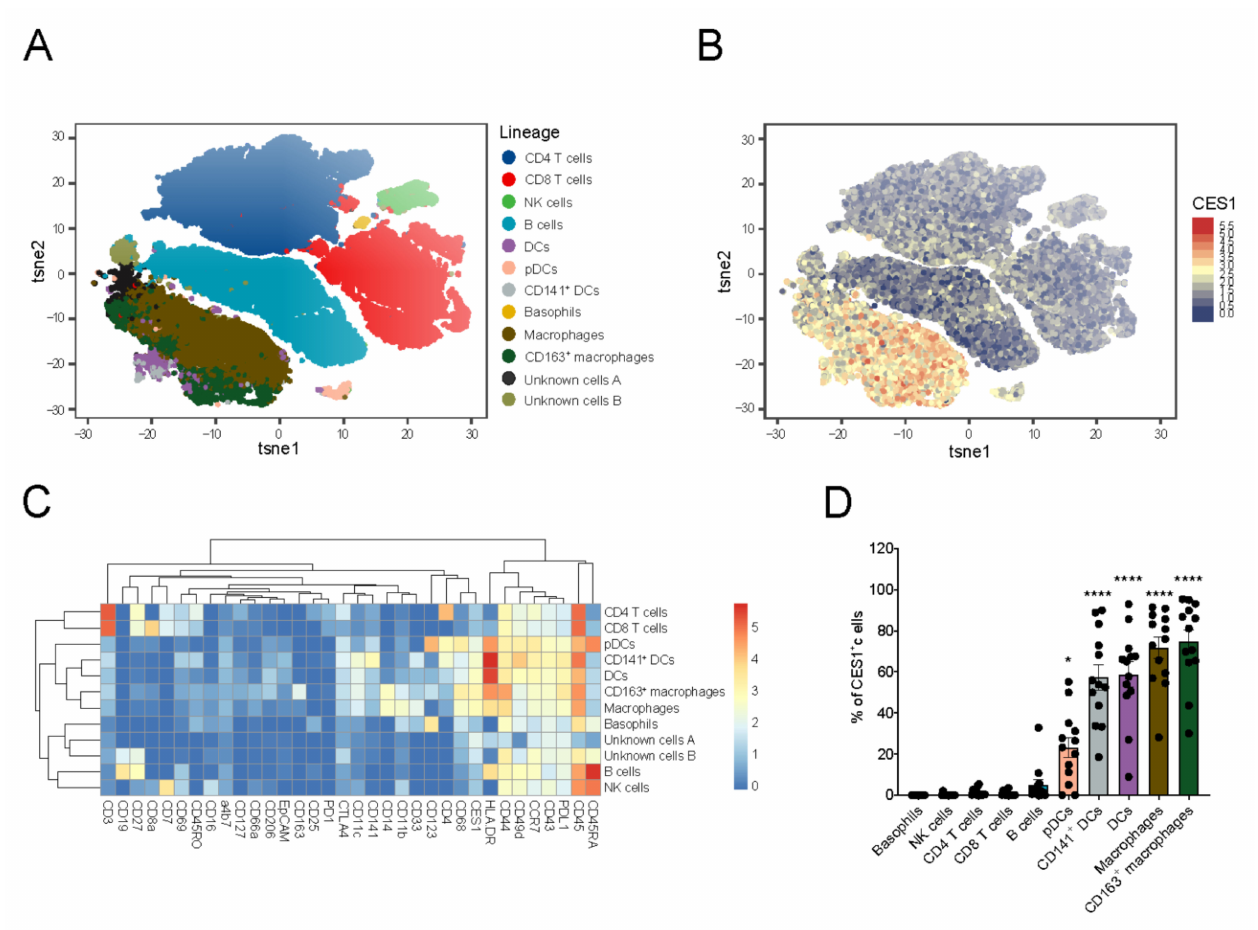
Figure 3. CES1 is expressed within macrophages and dendritic cells retrieved from inflamed fis- tula tracts of CD patients. ( A ) Fistula cells from CD patients (n = 13) fistula tract scrapings were barcoded, stained, and pooled for CyTOF and then visualized in a tSNE plot after mass cytometry analysis. Basophils, B cells, CD141 + DC type1, CD4 T cells, CD8 T cells, NK cells, macrophages, CD163 + resident macrophages, pDCs, and DCs were identified. ( B ) CES1 expression was demon- strated among identified cell clusters in ( A ). ( C ) A heat map showing expression intensity of different (lineage) markers in relation with the identified cell clusters in ( A ). ( D ) Percentages of CES1 + cells are shown among identified cell clusters in ( A ). Data are represented as mean with SEM of 13 patients; pDCs, CD141 + DCs, DCs, macrophages, and CD163 + macrophages were compared to the other cells. Statistical testing was performed using a one-way ANOVA test; * p ≤ 0.05, **** p ≤ 0.0001. SEM; standard error of the